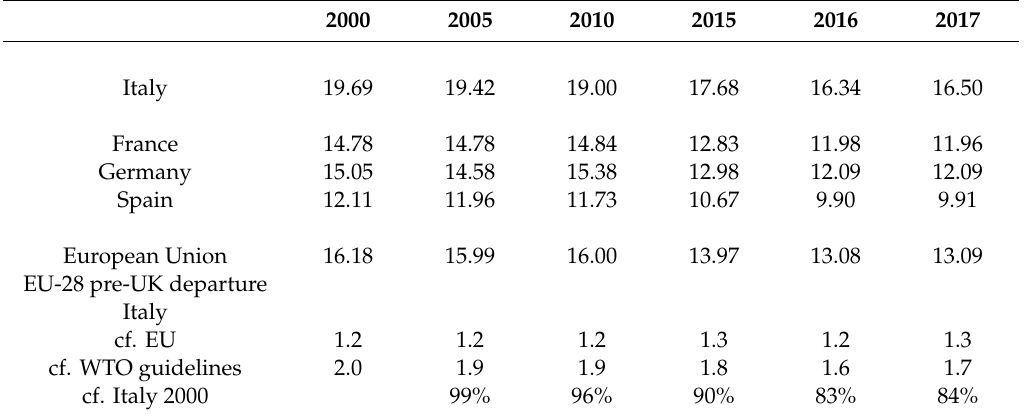
Table 2. Italy’s Levels of PM 2.5 over the Period 2000–2017 Compared with Other European